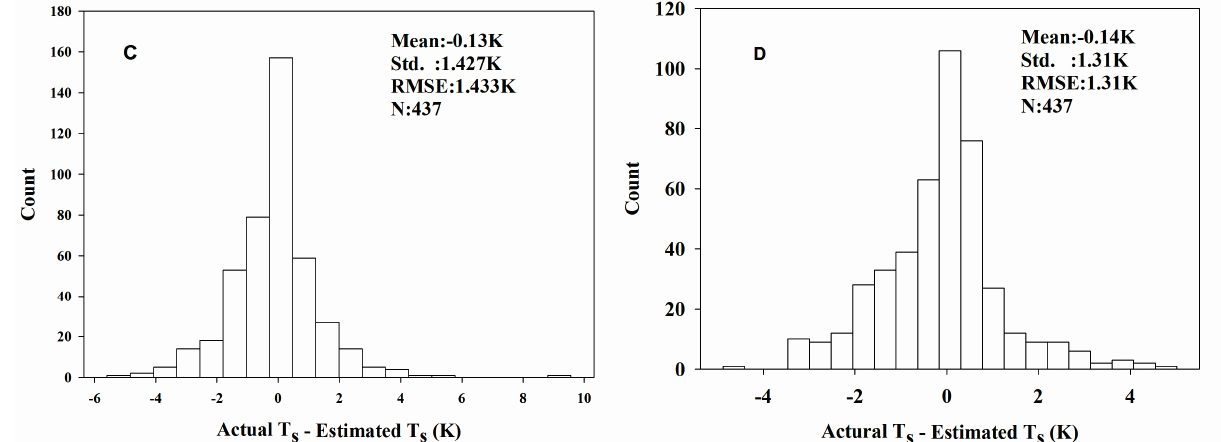
Figure 7. Histogram of errors of the measured T cloud and the estimated T cloud after adding biases to the NSSR (( A ): add a − 5 percent NSSR bias to the actual NSSR; ( B ): add a − 10 percent NSSR bias to the actual NSSR; ( C ): add a 5 percent NSSR bias to the actual NSSR; and ( D ): add a 10 percent NSSR bias to the actual NSSR).